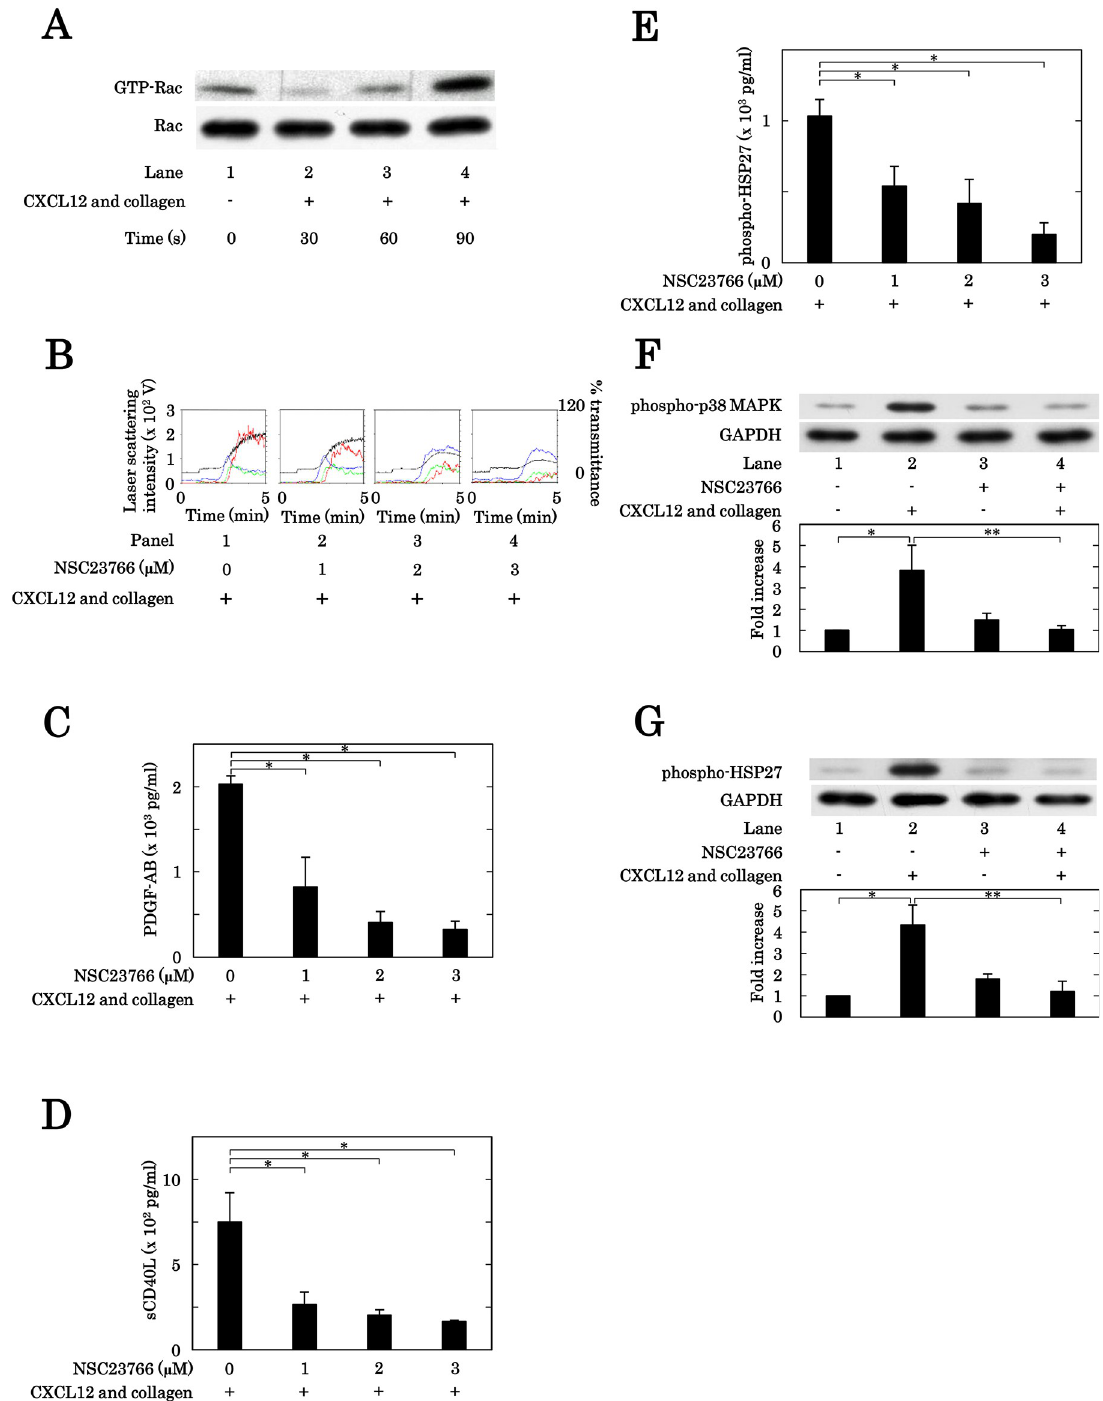
Fig 4. Effects of NSC23766 on the human platelet activation, the phosphorylation of p38 MAPK and the phosphorylation of HSP27 in human platelets induced by the simultaneous stimulation with collagen and CXCL12. (A) PRP was stimulated simultaneously by the combination of 0.2 μ g/ml of collagen and 10 ng/ml of CXCL12 for the indicated periods. The reaction was terminated by the addition of ice-cold EDTA (10 mM) solution. The levels of GTP-binding Rac in the harvested protein of platelets were determined by the immunoprecipitated Western blot analysis. The representative data are shown. (B, C, D, E) PRP was pretreated for 3 min with 0 μ M, 1 μ M, 2 μ M or 3 μ M of NSC23766, and then stimulated simultaneously by the combination of 0.2–0.4 μ g/ml of collagen and 10 ng/ml of CXCL12 for 5 min (B, C) or 15 min (D, E). The reaction was terminated by the addition of ice-cold EDTA (10 mM) solution. (B) The